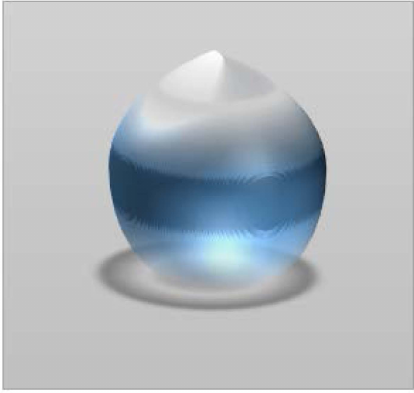
Figure 13. Hollow granule obtained from aerosil and HPMC, dried at 100 ◦ C.